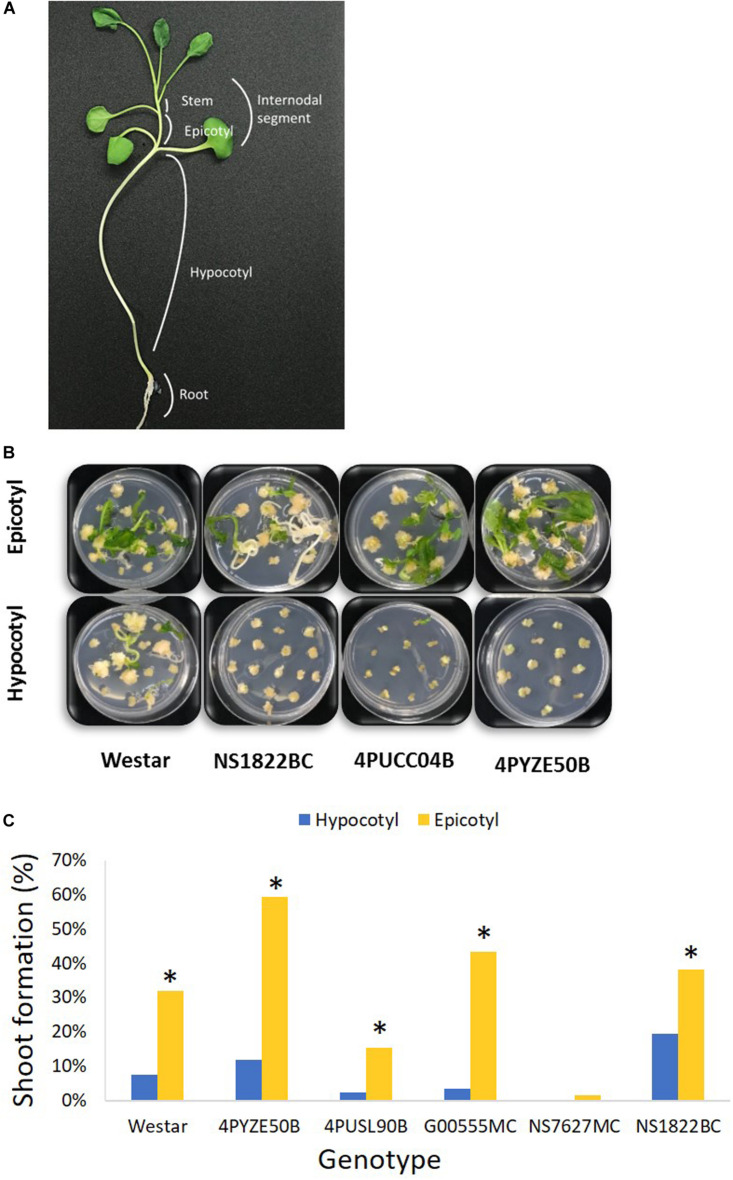
Hypocotyl and epicotyl explants from multiple genotypes. (A) A diagram of canola seedling; (B) representative shoot formation from epicotyl versus hypocotyl explants for multiple genotypes at day 42 after infection; (C) percentage shoot formation from epicotyl and hypocotyl explants at day 42 after infection. Epicotyl explants were significant better than hypocotyl in shoot formation in every genotype. Genotype NS7627MC had no response from hypocotyl. *P < 0.05 [Student’s t-test, JMP 14 software (SAS institute, Cary, NC)].